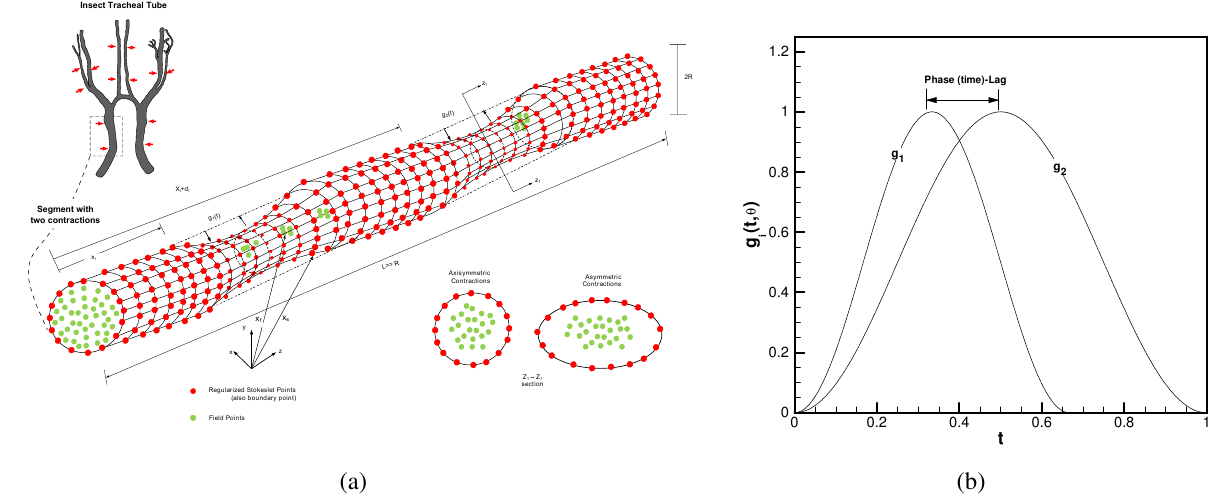
Figure 1. Problem schematic given to mimic the insect’s main tracheal tube segment with two contractions [1] and the Stokeslets-mesh-free numerical setup: ( a ) 3 D tube with moving upper wall contraction profile R ( z, t ) ; ( b ) g the first and second contractions,